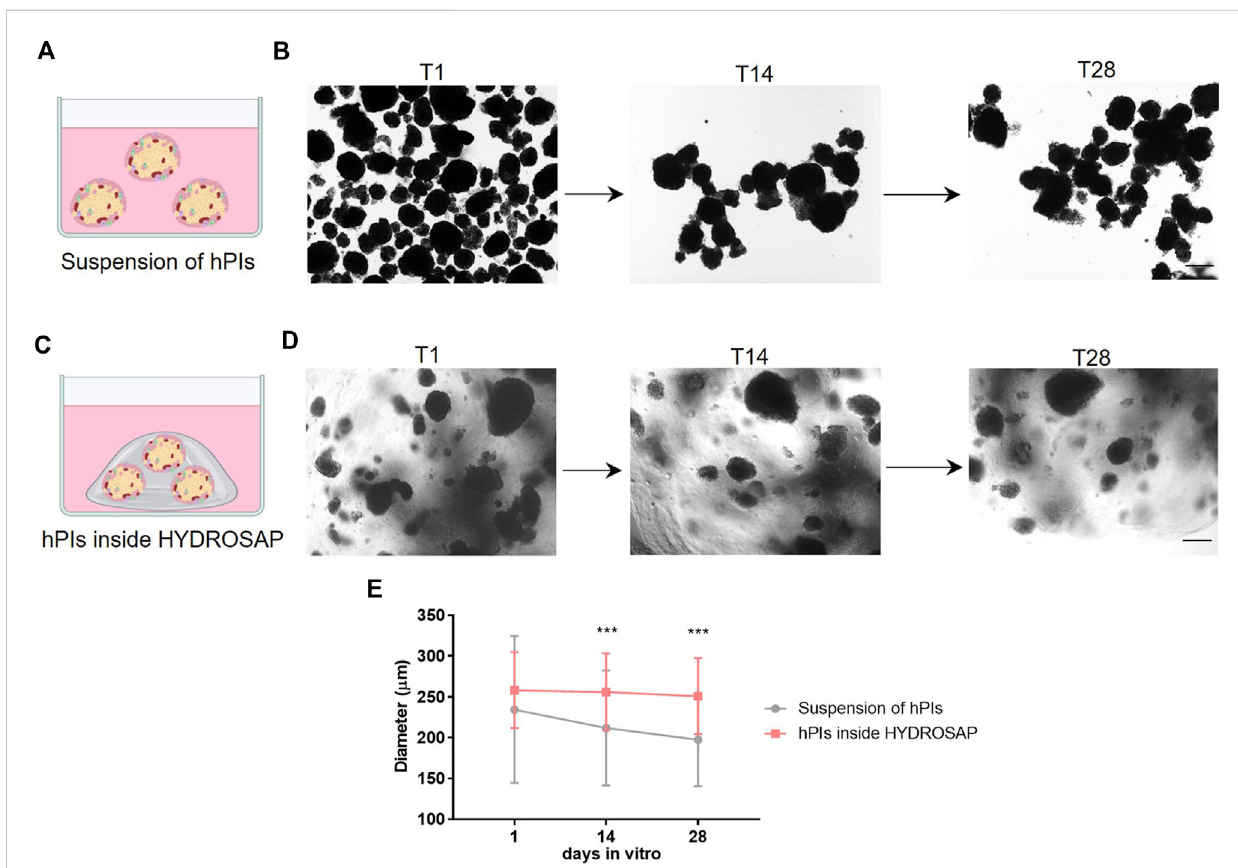
FIGURE 1 In vitro experimental design and hPIs morphological evaluation. (A) In standard condition, hPIs were maintained in free- fl oating suspension in culture medium. (B) Time-course of hPIs integrity captured in bright fi eld microscopy: round hPIs cluster at 1-day post-isolation (T1) turned into hPIs clusteredtogetherlosingtheiroriginalmorphologyandintegrityafter14(T14)and28(T28)days. (C) hPIsembeddedinSAPscaffoldsmimickingstructural features of extracellular matrix. (D) Morphology and integrity of embedded hPIs inside HYDROSAP was monitored through the weeks via inverted microscope,showingnomorphologicalalterationoverweeks. (E) Isletsdiameterquanti fi cationovertimetill28-dayspost-isolationforfree- fl oatinghPIs and hPIs seeded in HYDROSAP hydrogels. Graph shows mean ± SD of triplicate samples per each time point and statistical difference between groups (two-way ANOVA followed by Tukey post-hoc test; *** p < 0.001 ). Scale bar, 100